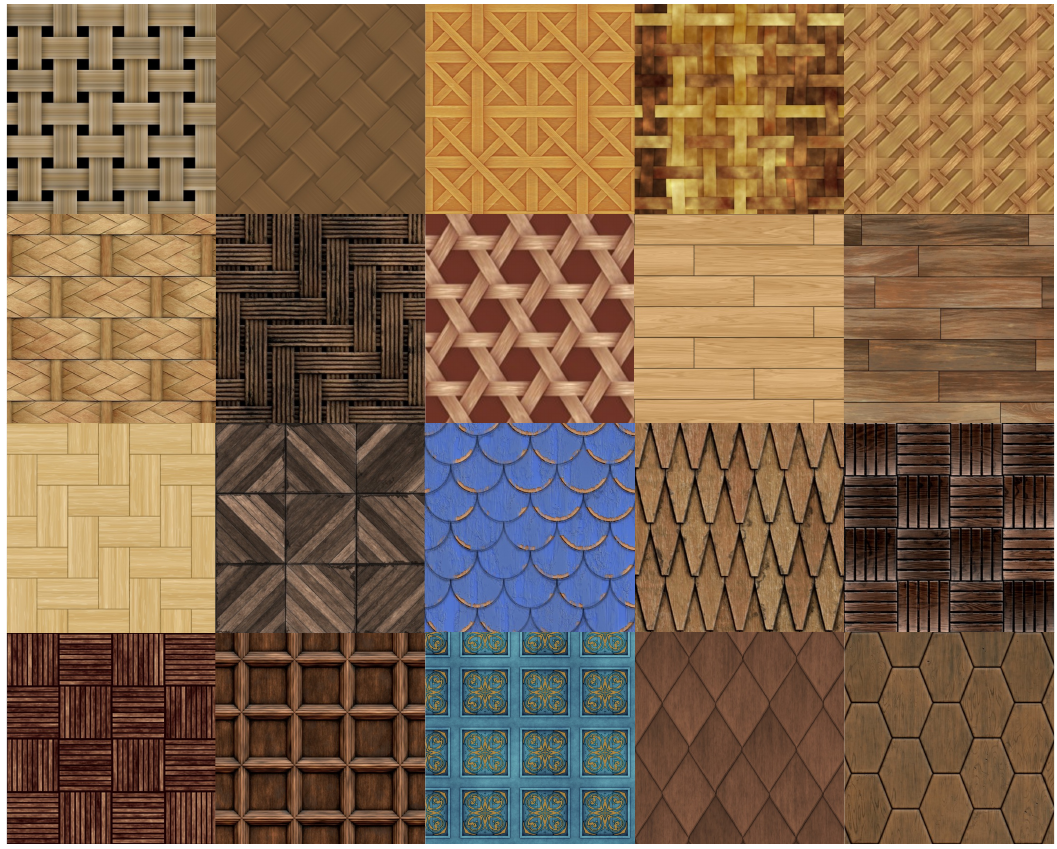
Figure 2. Wood images used in our work. From top left: 8 wicker, 4 floor, 2 roof, and 6 wall images. The visual experiment was conducted at two locations, UK and Norway, in